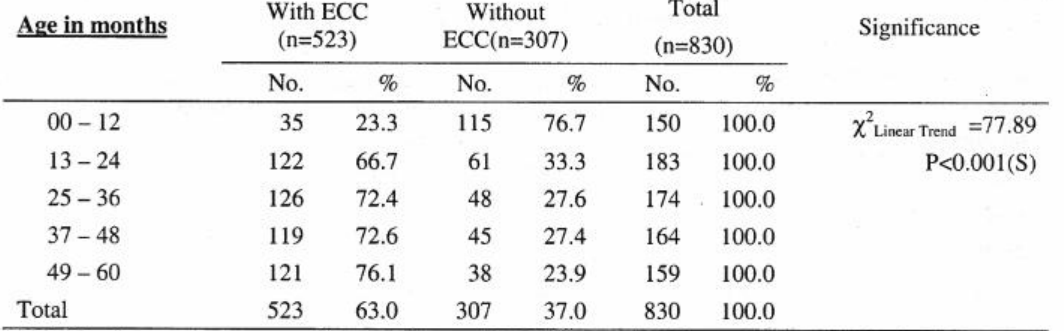
Table 3 indicates that age specific prevalence of ECC increased with age. Chi square for linear trend was statistically significant. (7ineartrend =77.89 p<0.001)